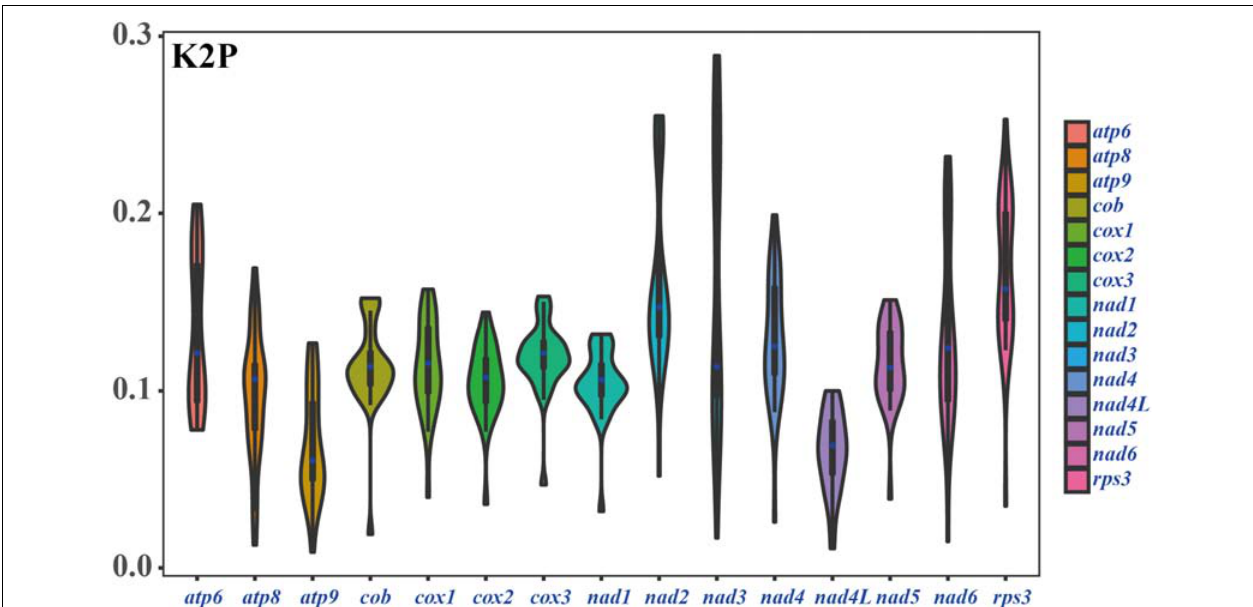
FIGURE 6 | K2P genetic distance of 15 PCGs conserved in the eight Amanita mitogenomes.